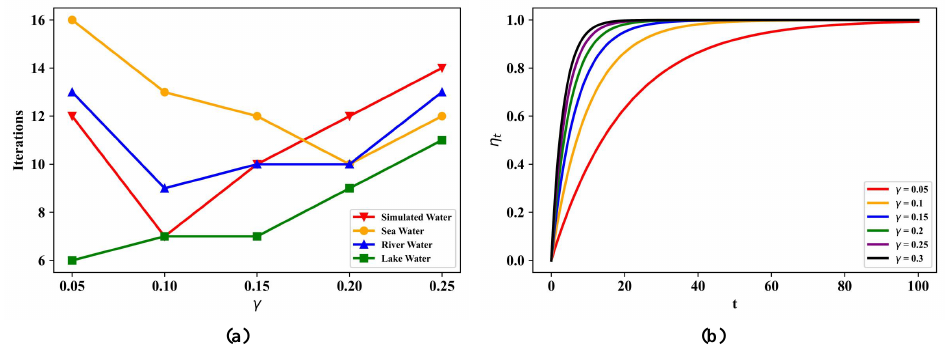
Figure 17. The results of hyperparameter γ analysis experiments. ( a ) The relationship between γ and the number of convergence iterations; ( b ) The function curve of dynamic threshold η t with different γ